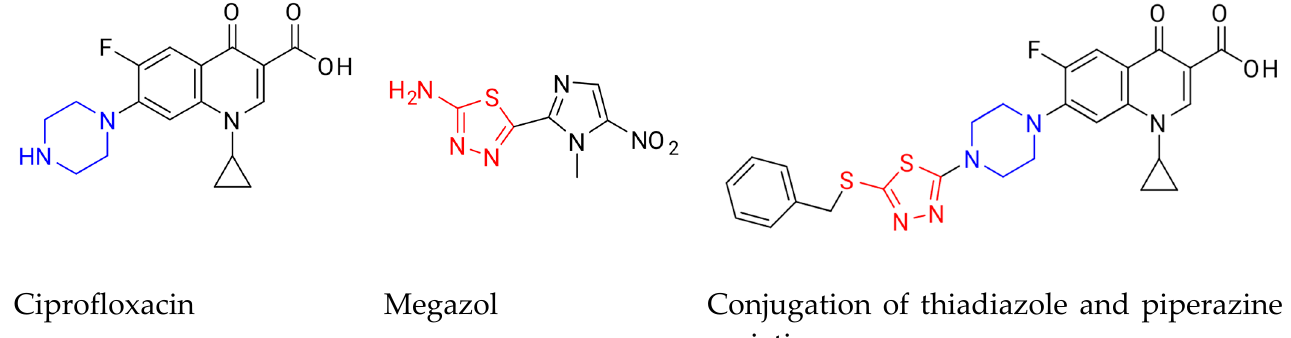
Figure 1. Example of market drugs containing thiadiazole and piperazine moieties.